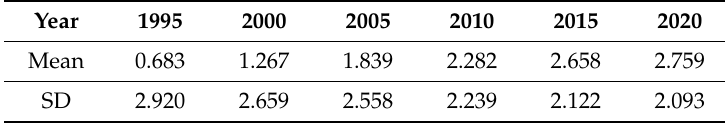
Table 6. Mean and standard deviation of SUHII (°C) in the study area for six time periods from 1995 to 2020.